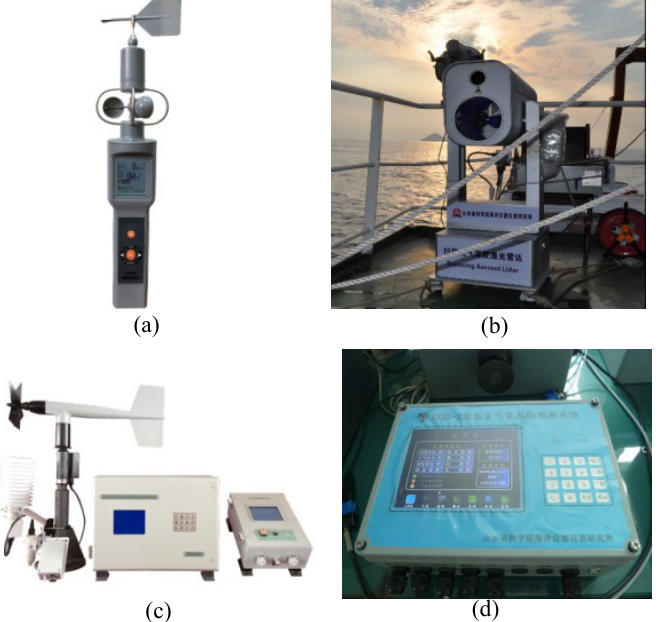
Figure 2. Some meteorological monitoring equipment: ( a ) BCF handheld anemometer; ( b ) Scan- ning aerosol lidar; ( c ) Ship meteorological instrument; ( d ) SXZ2-2 Hydrometeorological automatic observation